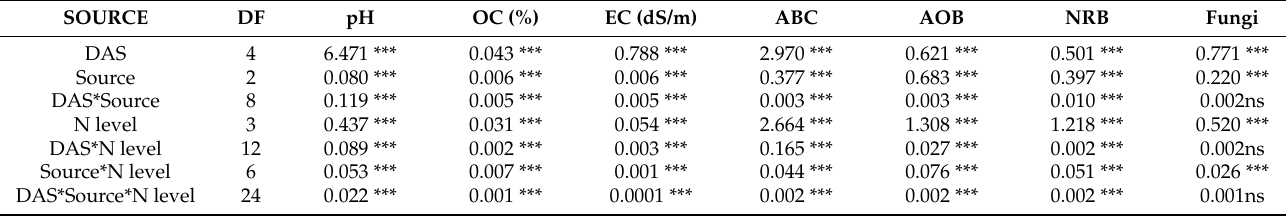
Table 2. Analysis of variance of days after treatment (DAT), N fertilizer and N level of different types of fertilizers on soil chemical properties during potato